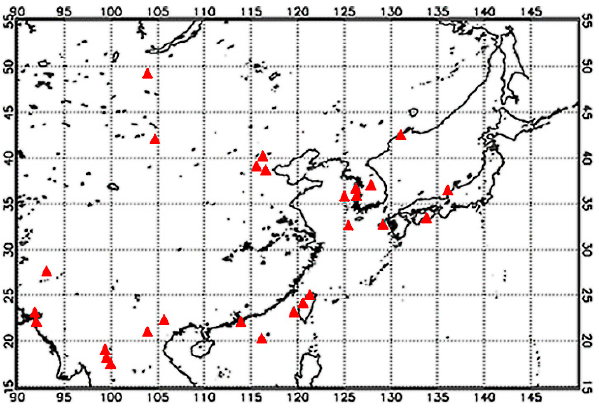
Figure 1. Locations of the 27 selected Aerosol Robotic Network (AERONET) sites used for comparisons of satellite AOD. Table 2. AERONET site details.